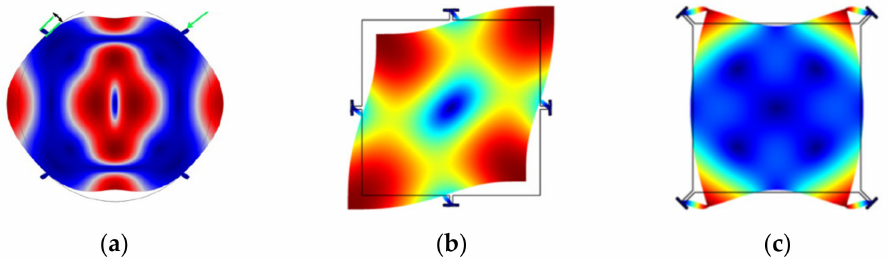
Figure 3. Other FEM simulated bulk modes in COMSOL. ( a ) BL mode (Adapted with permission from Ref. [63]); ( b ) Face-shear mode; ( c ) Butterfly